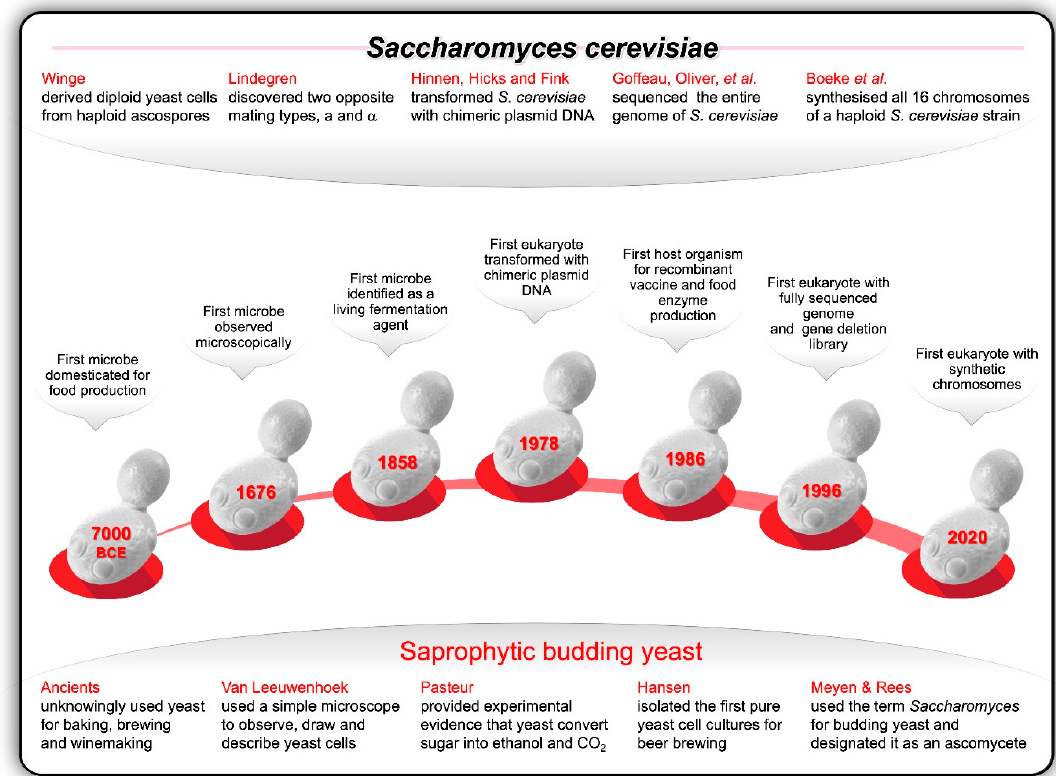
Figure 2. The budding yeast, Saccharomyces cerevisiae , has emerged as the most popular eukaryotic model organism to develop and test new genetic technologies and industrial applications. These attributes include its relatively short reproduction time; simple and inexpensive cultivation as stable haploid, diploid and polyploid cells in defined media; efficiency of sporulation and cross- hybridisation between two stable opposite mating-types; ease of mutant isolation and mapping; efficacy of genetic transformation, maintenance of multiple copies of circular plasmids as well as chromosomal integration through homologous recombination; rare pathogenicity; relatively small genome size; and availability of gene deletion libraries consisting of strains carrying unique DNA barcodes that mark each deletion